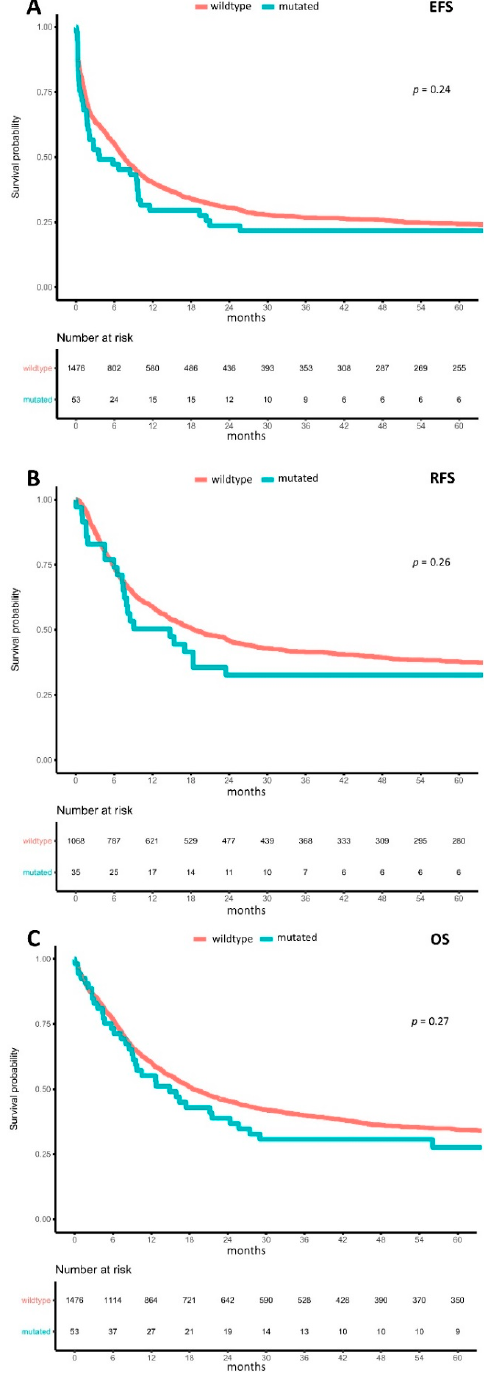
Figure 5. Impact of BCORL1 mutations on outcome. Kaplan–Meier plots for ( A ) event-free survival, ( B ) relapse-free survival, and ( C ) overall survival in AML, with wild-type (orange) and mutated (turquoise) BCORL1 compared using the logrank test.